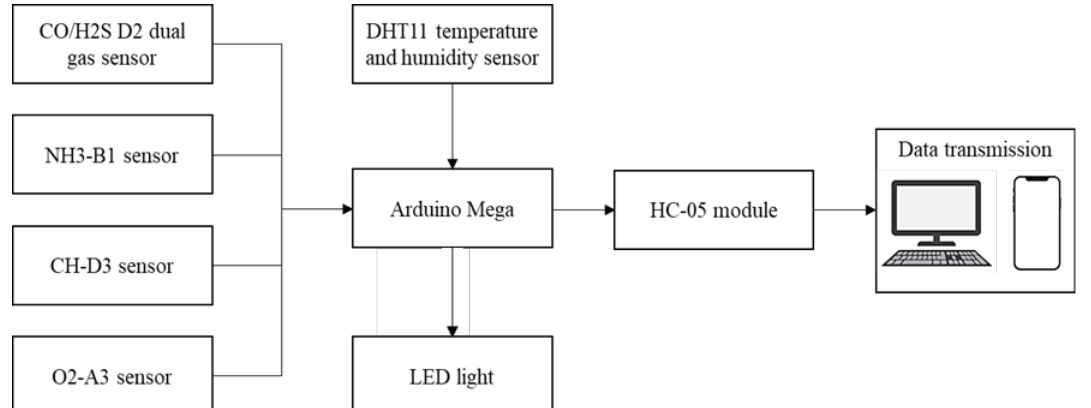
Figure 3. Block diagram of the system.